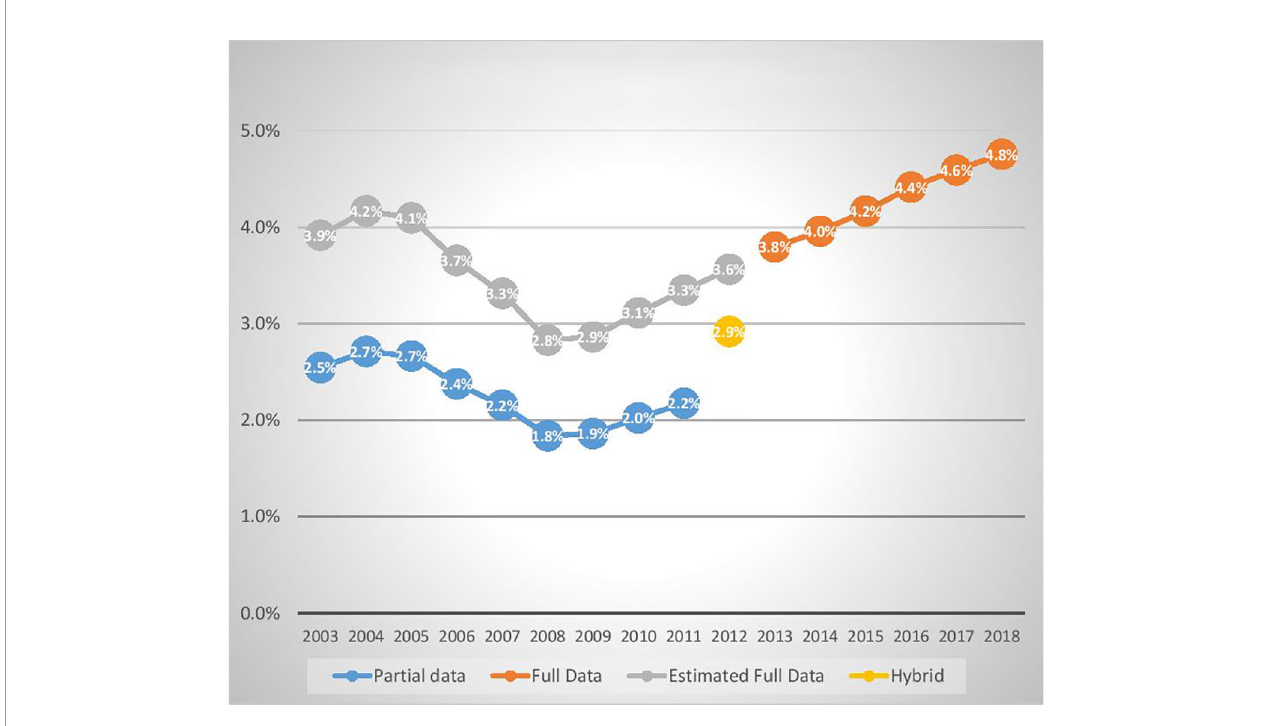
FIGURE 3 | Percentage of young Australians (aged <28) dispensed an antidepressant in the years ended 30 June 2003 to